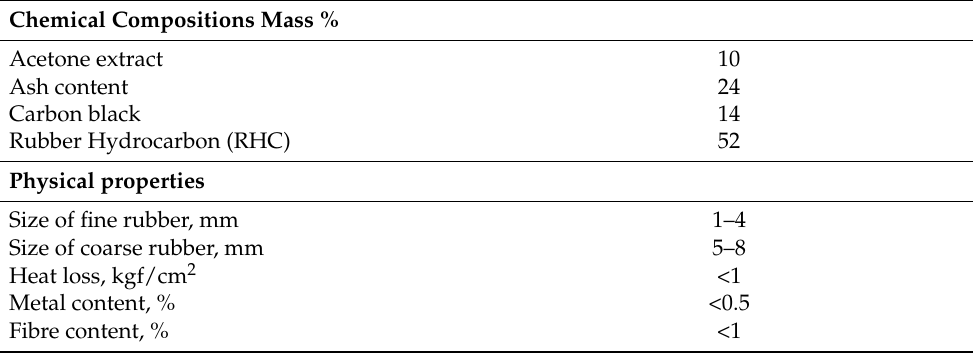
Table 3. The chemical and physical features of the WRTCs